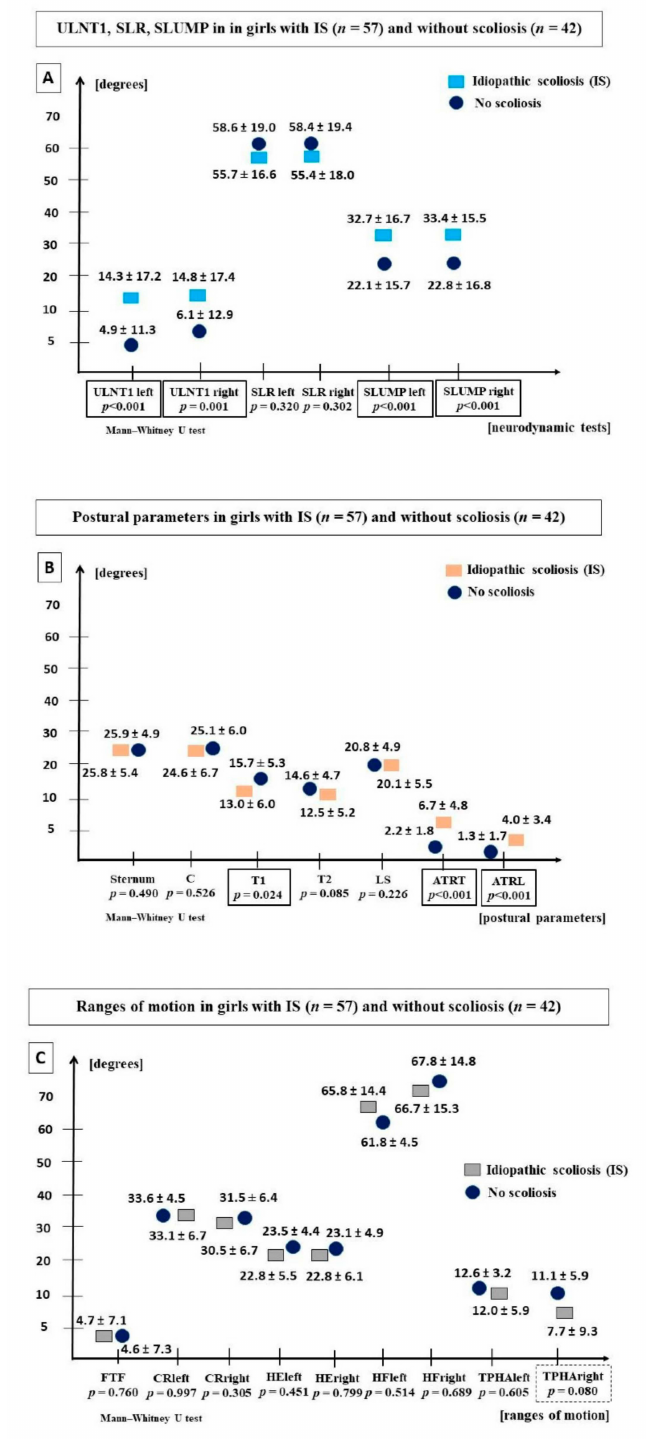
Figure 4. ( A ) ULNT1, SLR and SLUMP; ( B ) postural parameters; ( C ) ranges of motion in girls with IS ( n = 57) and asymptomatic girls ( n = 42). Abbreviations: ULNT1, Upper Limb Neurodynamic Test; SLR, Straight Leg Raise Test; SLUMP, Slump Test; ATRT, angle of trunk rotation in the thoracic spine; ATRL, angle of trunk rotation in the lumbar spine; Sternum, sternum inclination; C, inclination of the cervicothoracic junction; T1, inclination of the upper thoracic spine; T2, inclination of the thoracic-lumbar junction; LS, inclination of the lumbosacral junction; FTF, Fingertip-To-Floor test; CR, Cervical Rotation; HE, Hip Extension; HF, Hip Flexion with knee extension; TPHA, Trunk-Pelvis-Hip Angle; JHM, Joint Hypermobility; p , statistical significance (Mann–Whitney U